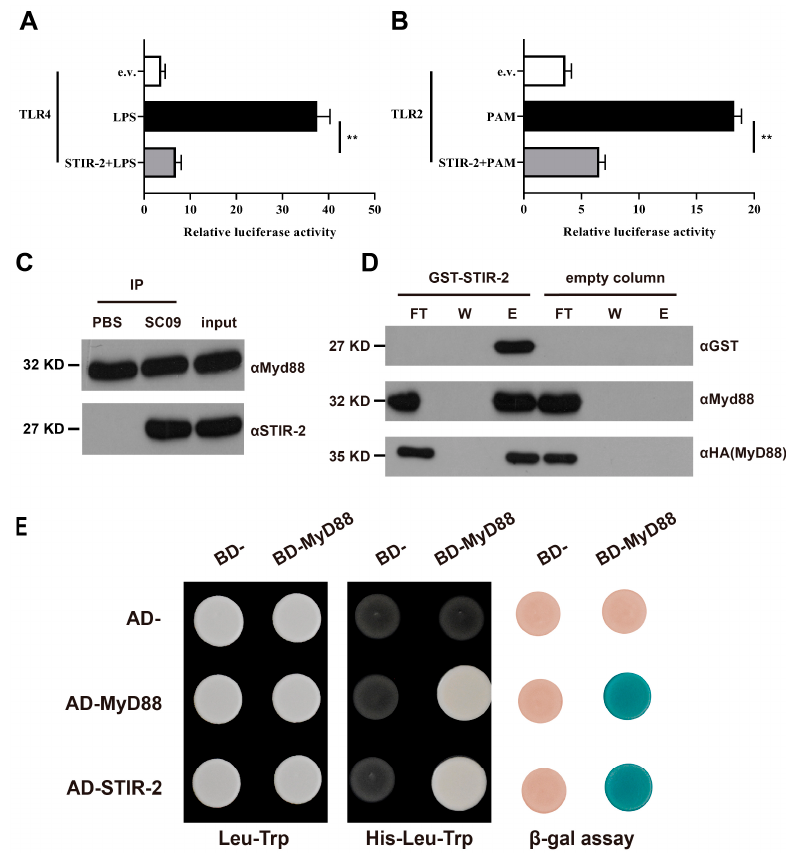
Figure 5. STIR-2 impairs TLR signaling by binding to MyD88. ( A ) The luciferase reporter plasmid and the TLR4 plasmid were transiently transfected into rainbow trout head kidney macrophages with or without the STIR-2 plasmid. After 24 h, the cells were stimulated with LPS for 6 h, and luciferase activity was determined. The white band represents the negative control (empty vector), the black band represents LPS-stimulated cells, and the gray band represents cells transfected with the STIR-2 plasmid and stimulated by LPS. Data correspond to median ± standard errors of the relative luciferase activity from five independent experiments. ** p < 0.01. ( B ) This part of the experiment was similar to ( A ), except that the plasmid was TLR2, and the cells were stimulated with PAM. ** p < 0.01 . ( C ) Co-immunoprecipitation (co-IP) experiments were performed on cells infected with wild-type SC09 or PBS (control). After co-IP, the anti-STIR-2 antibody was used to detect protein interactions, and the anti-MyD88 antibody was used to detect proteins bound to beads, and the inputs were detected with anti-MyD88 antibody and anti-STIR-2 antibody, respectively. ( D ) Pull-down experiments were performed by the in vitro expression of HA-MyD88 protein and the prokaryotic expression of GST-STIR-2 protein immobilized on a Ni-NTA resin. An empty vector was used as a control. The anti-HA and anti-MyD88 antibodies were used to detect protein interactions (lower blot) by Western blotting, and the anti-GST antibody was used to detect the binding of the GST-STIR-2 protein to the resin. The flowthrough (FT), two washes (W), and elution ( E ) are shown in each lane. ( E ) Recombinant plasmids containing Gal4 BD and Gal4 AD were co-transformed into yeast cells and screened on plates lacking leucine (Leu) and tryptophan (Trp) (left panel). Gal4 BD- and Gal4 AD-recombinant plasmids were co-transformed into yeast cells and screened on plates lacking histidine (His) in the presence of 20 mM 3AT (middle panel). Transformants grown on this medium present an interaction between STIR-2 and MyD88. The expression of the reporter β -galactosidase gene in yeast produces blue yeast, and indicated the occurrence of protein interactions (right panel). Empty vectors for AD- and BD-plasmids served as negative controls, and MyD88 homodimerization served as a positive